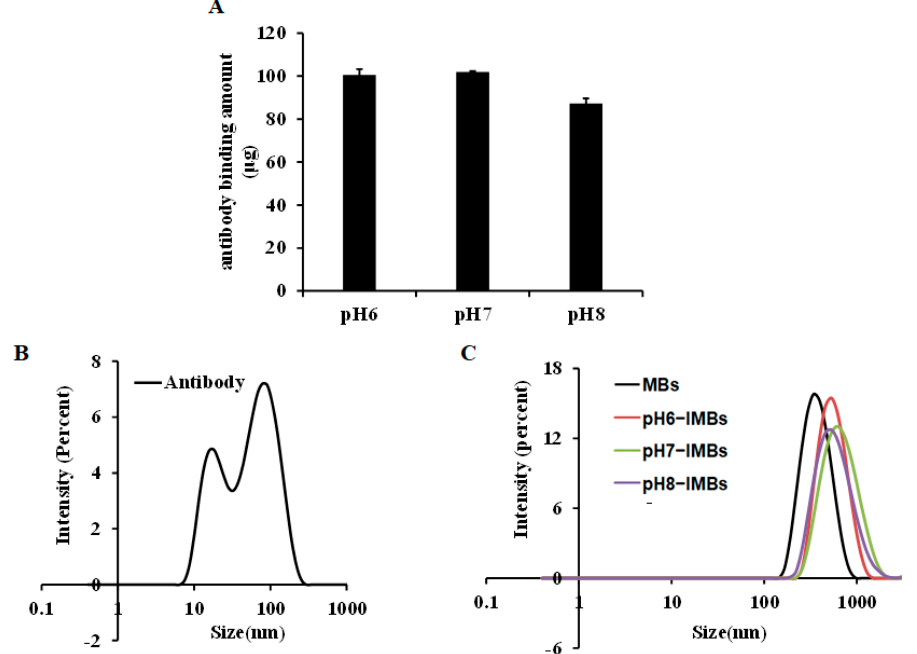
Figure 2. The characterization of IMBs properties. ( A ) Amount of antibody binding to MBs at pH 6.0, 7.0 and 8.0, ( B ) the size distribution assays of antibody, ( C ) and the size distribution assays of MBs, pH6 − IMBs, pH7 − IMBs, and pH8 − IMBs.